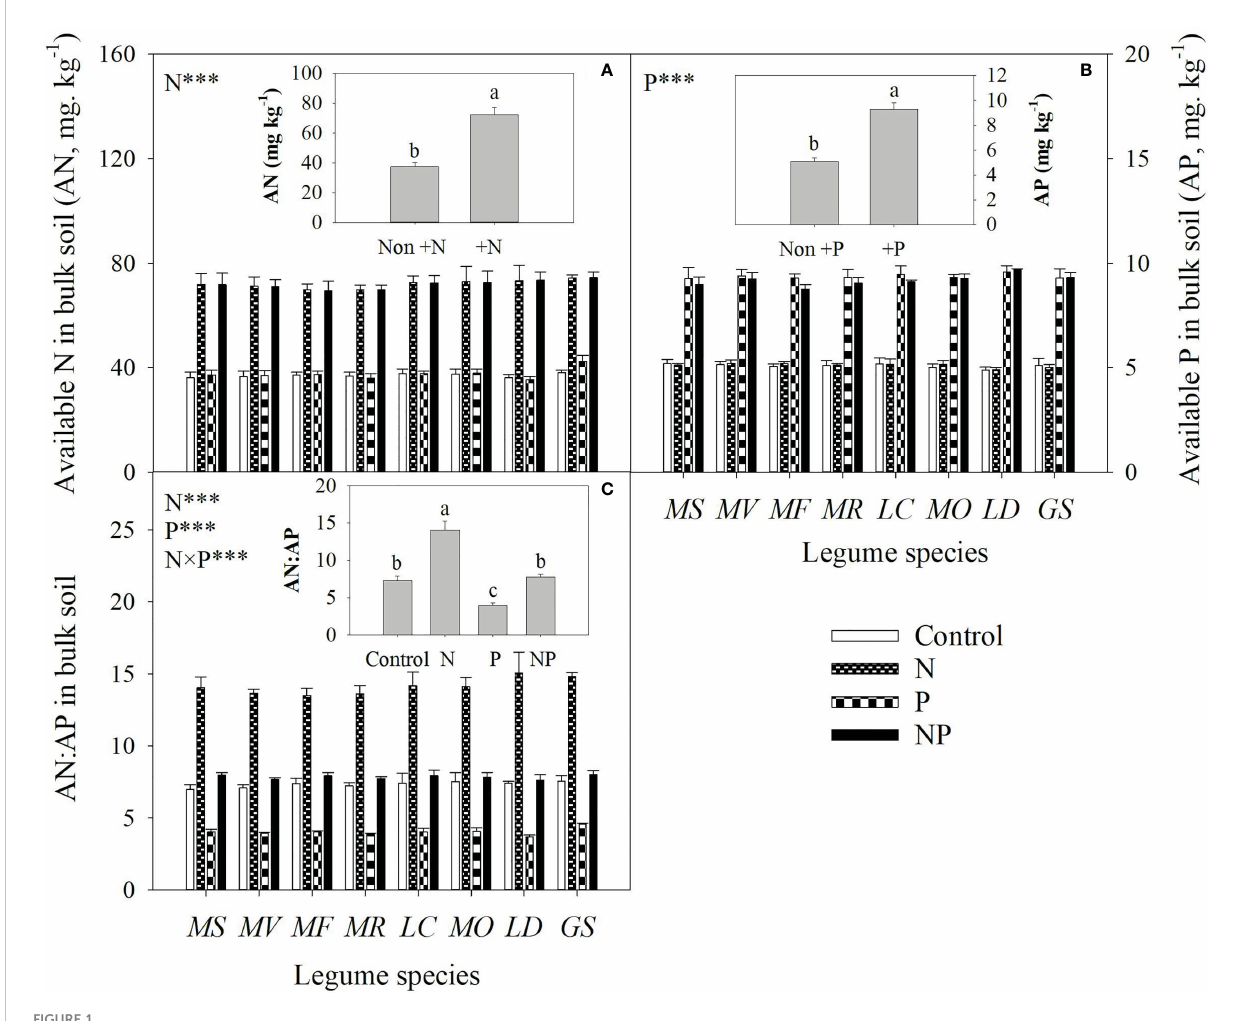
FIGURE 1 Available nitrogen (AN, A ) and available phosphorus (AP, B ) concentrations and AN : AP (C) in bulk soil under control (no fertilizer addition), N (N addition), P (P addition) and NP (addition of both N and P) for eight legume species. MS, Medicago sativa ; MV, Medicago varia ; MF, Medicago falcata ; MR, Medicago ruthenica ; LC, Lotus corniculatus ; MO, Melilotus of fi cinalis ; LD, Lespedeza daurica ; GS, Glycine soja. Letters (N, P, S, N×P, N×S, P×S, N×P×S) indicate signi fi cance overall from N addition, P addition, legume species (S) and their interaction effects according to general linear model P- values, the signi fi cance level are reported as ***(P<0.001). Inside the embedded fi gures, the bars represent the means of each independent factor and interacted treatment with signi fi cant